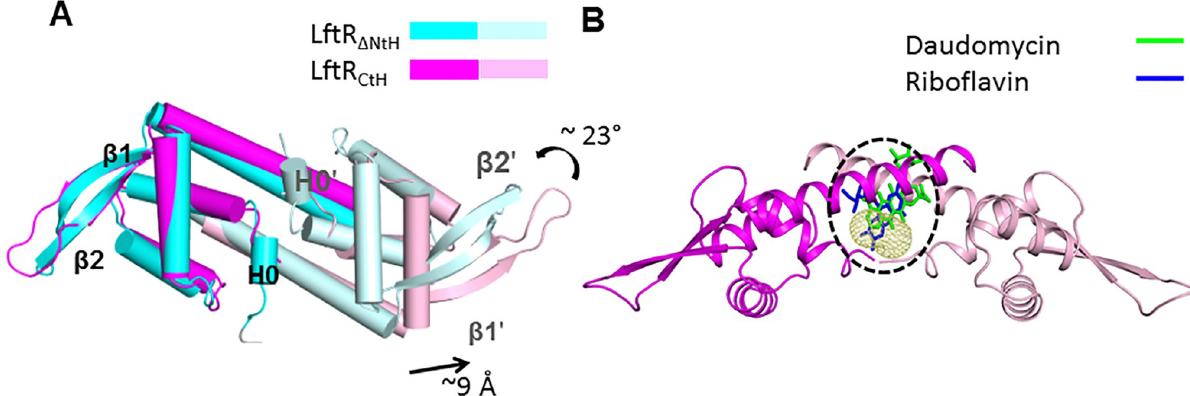
Fig 5. Structural diversity and intersubunit cavity of LftR. (A) The LftR Δ NtH structure (cyan and light cyan) was superimposed on the LftR CtH structure (magenta and light magenta) using the wHTH motifs in one subunit. (B) Intersubunit cavity located in the center of the LftR CtH dimer structure. The structure of the LftR CtH dimer is shown as magenta and light magenta ribbons. The intersubunit cavity of LftR is represented by yellow mesh and highlighted by a dashed circle. The structures of the LmrR-ligand complexes (LmrR-riboflavin, PDB accession code 4ZZD; LmrR- daunomycin, PDB accession code 3F8F) were overlaid on the LftR structure, and the ligand molecules of LmrR are shown as sticks (riboflavin, blue; daunomycin, green) with the LftR CtH